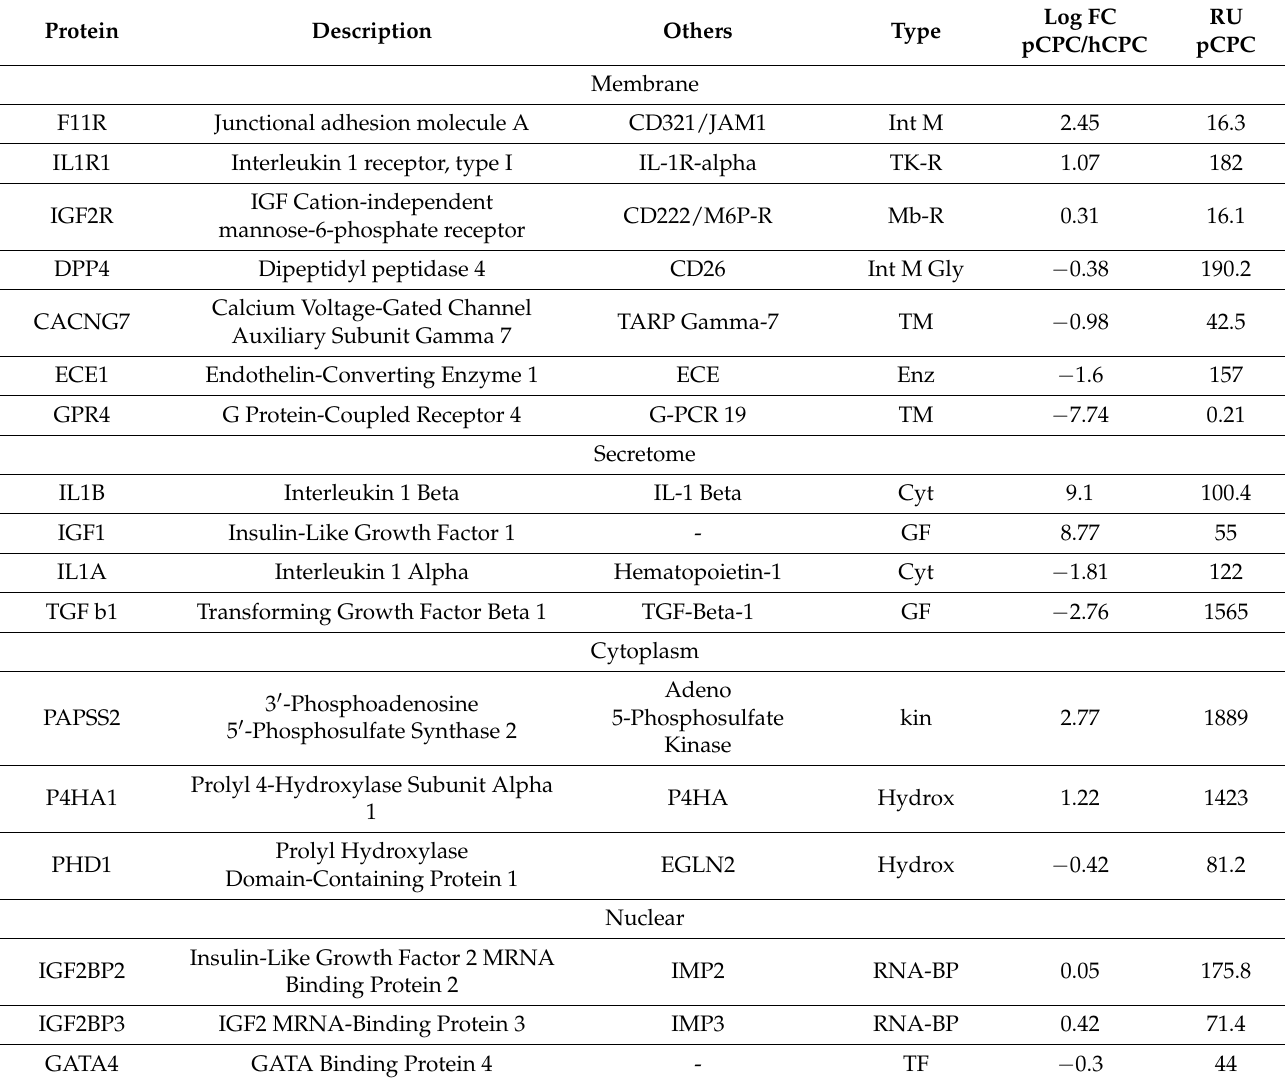
Table 1. Main pCPC DEG previously identified in hCPC as differentially overexpressed in comparison with BM − MSC and